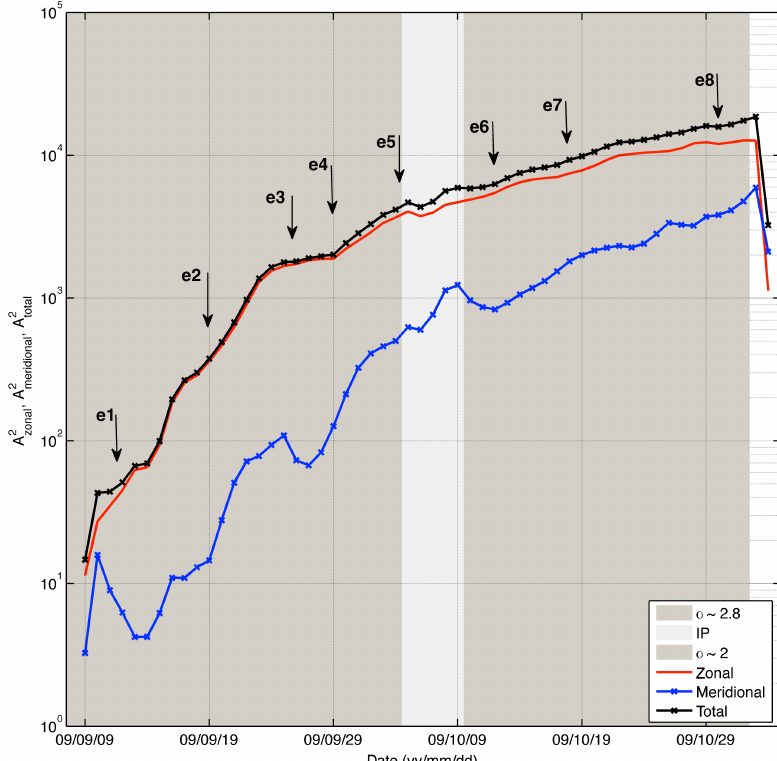
Figure 3. Absolute (single-particle) dispersion statistics for triplets A to D, depicting zonal (red), meridional (blue), and total (black) dis- persion, providing a regional characterization of sea ice drift in the southern Beaufort Sea. Arrows and labels depict triplet events e 1– e 8. Directional change events captured by the (Eulerian) variance interpretation (Fig. 2) are also captured by inflection points in the (Lagrangian) single-particle zonal and meridional dispersion analyses near 12, 19, 25, and 30 September and 5, 12, 18, and 29 October. A plateau in the zonal and meridional single-particle dispersion curves depicts minimal displacements in the direction of motion relative to the mean as the triplet centroids and paths change course. Total (zonal and meridional components combined) single-particle dispersion for triplets A to D provides a regional characterization of changes in sea ice drift. Specifically, total absolute dispersion is governed by zonal dispersion prior to, and meridional dispersion following, early October, with scaling exponents of α ∼ 3 and 2, respectively, highlighting a transition in ice dynamical regimes. Dark shaded areas depict dynamical regimes associated with α ∼ 3 and α ∼ 2 prior to and following the (light-shaded) inflection point (IP)